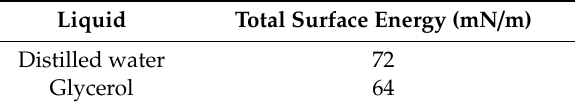
Table 5. Surface tension values of the liquids